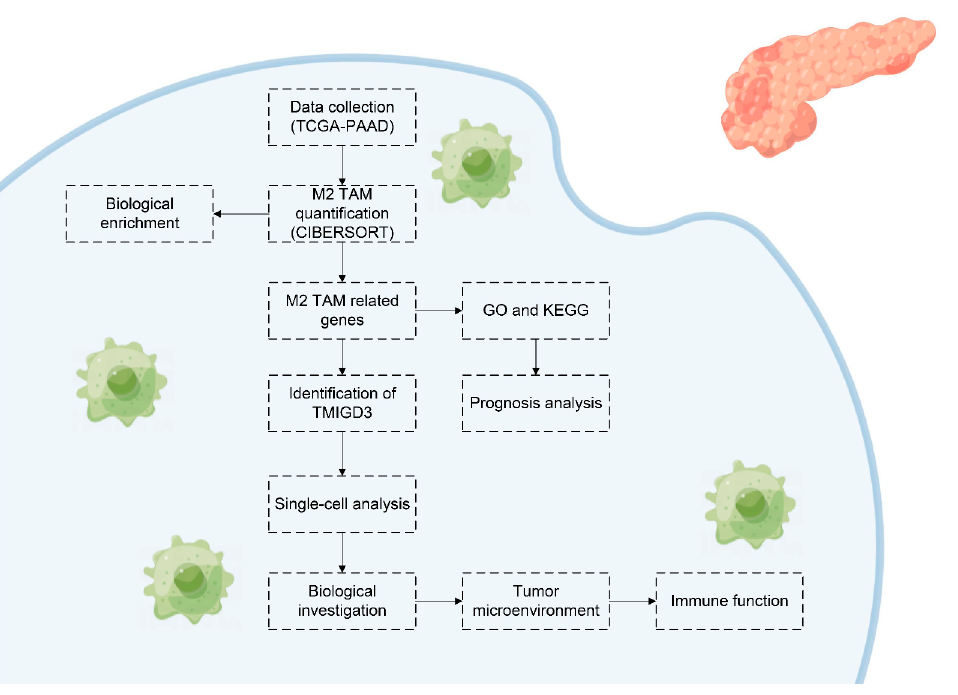
Figure 1. The fl ow chart of the whole study. Figure 1. The flow chart of the whole